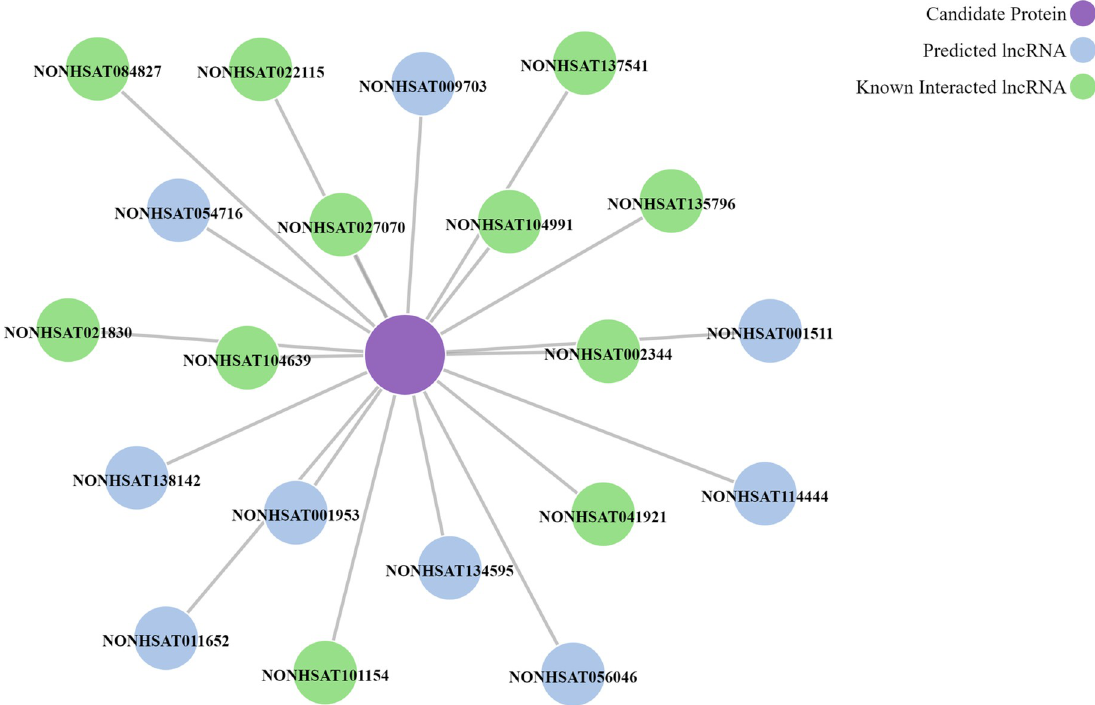
Fig 8. Visualization of top 20 predicted interacting lncRNAs of the protein: 9606.ENSP00000240185. Purple node stands for the protein. Navy blue nodes indicate the predicted interacting lncRNAs and green nodes represent lncRNAs that have observed interactions with the